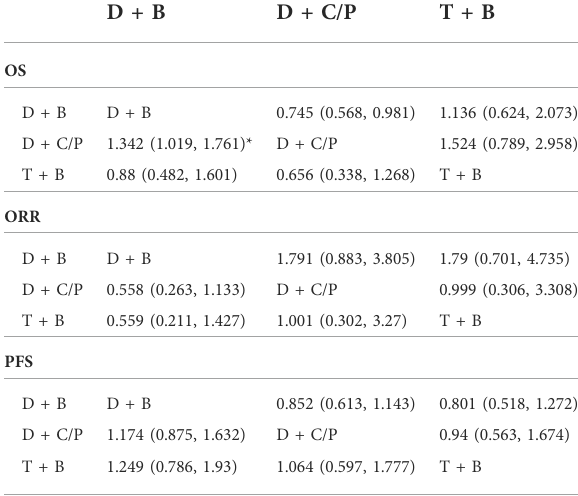
TABLE 1 Synthesis of odds ratios according to the network meta- analysis (ORR, OS, and